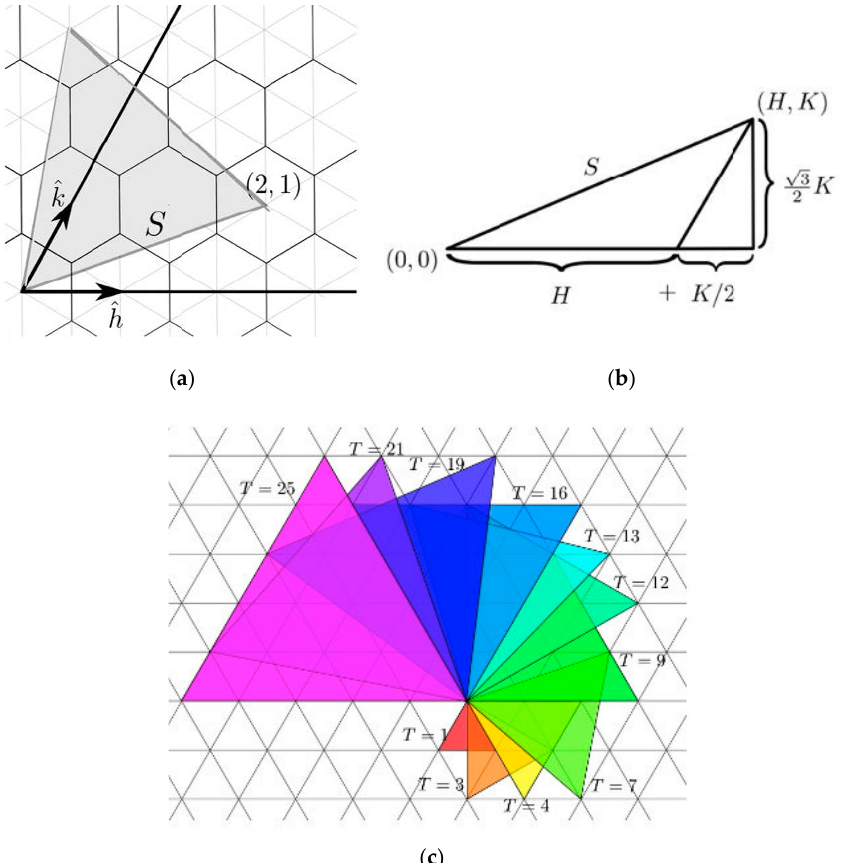
Figure 2. ( a ) Caspar and Klug [2] developed a classification of polyhedral viral capsids based upon a “Triangulation number” where a T-number is mathematically defined as the squared length of each triangle edge: T = (h 2 + hk + k 2 ). It counts the number of symmetrically distinct but quasi-equiv- alent triangular facets in the triangulation per face of an icosahedron. ( b ) A T1 virus has 60 capso- meres whereas a T3 virus has 180 capsomeres. Note that the volume of a viral capsid increases dra- matically as the T number increases. ( c ) Casper and Klug proved allowable triangulations consist of equilateral triangles whose vertices lie on a triangular grid. Source: CC By 4.0